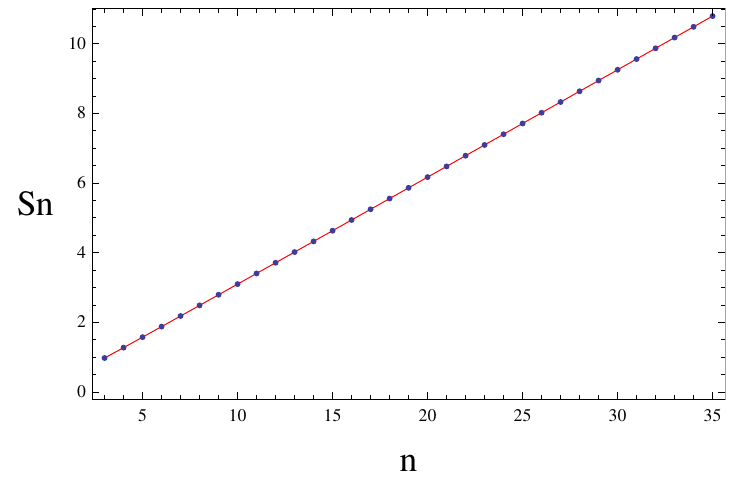
Figure 6 . The entanglement entropy of gauge (cid:12)elds with algebra ^ A